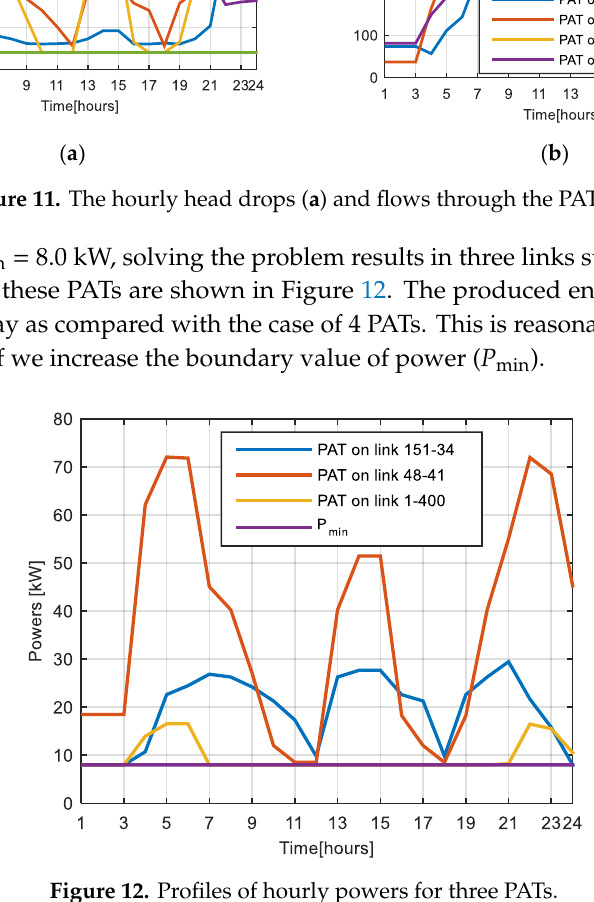
( b ) Figure 13. The hourly head drops ( a ) and flows through PATs ( b ). In scenario 3, P min = 12 kW, we found only one link (41–40) suitable for placing PATs. The average power produced is 48.52 kW and the average excessive pressure is 17.35 m. As compared with the case of no PAT, the average excessive pressure reduces about 6.0 m. In order to see the reduction of excessive pressure, the pressure contours of the WDS for the case of no PAT (left) and the case of 4 PATs (right) corresponding to the demand patterns of 0.36 and 1.34 are shown in the Figures 14 and 15, respectively. It is seen that a significant amount of excessive